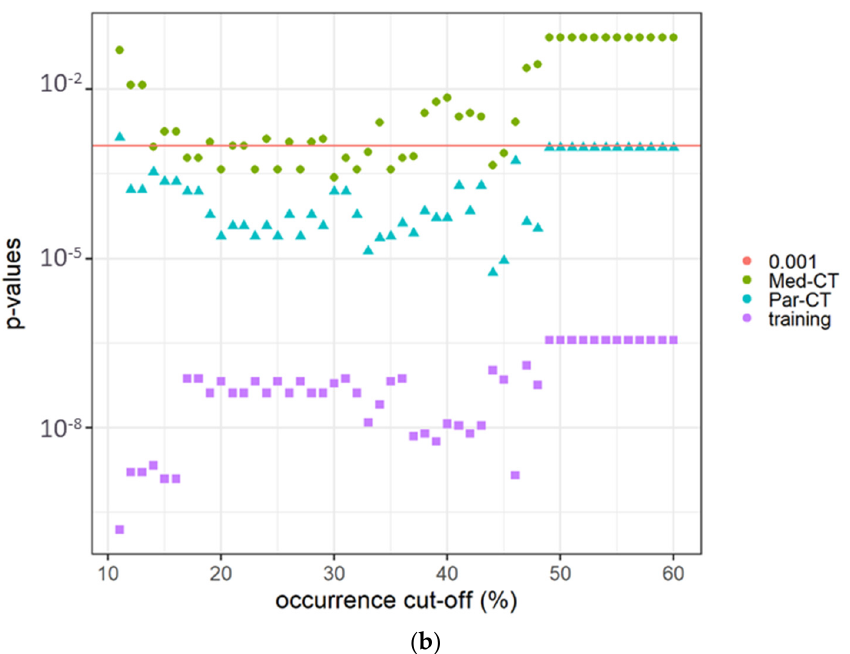
Figure 3. ( a ) The number of RFs and the BIC value versus the occurrence cut-off (expressed in %) in the 100 calculated LASSO-Cox models. ( b ) The p -values of Kaplan-Meier curves comparing patients in the training and verification datasets (i.e., Med-CT and Par-CT) with a score higher or lower than the cut-off determined on the training dataset (m training ). The red horizontal line indicates p = 0.001.